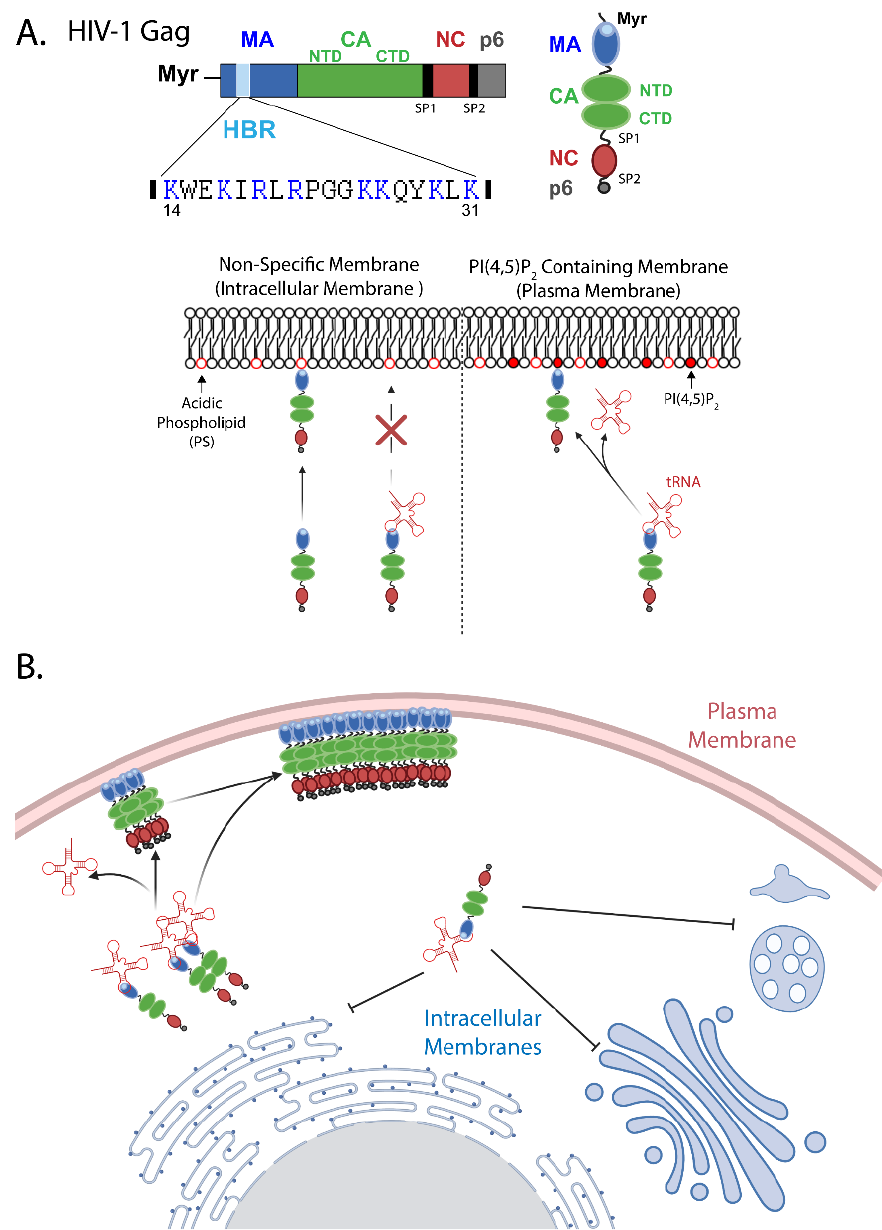
Figure 1. Plasma membrane-specific binding of HIV-1 Gag. ( A ) Molecular determinants for Gag membrane binding. Top , the domain organization of HIV-1 Gag. Blue, matrix (MA); green, capsid (CA, N-terminal domain [NTD] and C-terminal domain [CTD]); red, nucleocapsid (NC); gray, p6; and black, spacer peptides 1 and 2 (SP1 and SP2). Additionally, the locations of the myristoyl moiety (Myr) and the highly basic region (HBR, light blue) are shown. The HBR amino acid sequence is shown with basic residues highlighted in blue. Bottom , host molecules that bind the MA HBR. Gag binds membranes through interactions between the HBR and acidic phospholipid headgroups. tRNA binding to the HBR prevents interaction with membranes that contain a prevalent acidic phospholipid, phosphatidylserine (PS), but allows for Gag binding to membranes containing phosphatidylinositol (4,5) bisphosphate [PI(4,5)P 2 ]. For clarity, the myristoyl moiety is not depicted. ( B ) A model that accounts for specific localization of Gag to the plasma membrane. tRNA-mediated inhibition of membrane binding prevents localization of Gag to intracellular membranes, which lack PI(4,5)P 2 , but allows for binding to the plasma membrane where PI(4,5)P 2 is